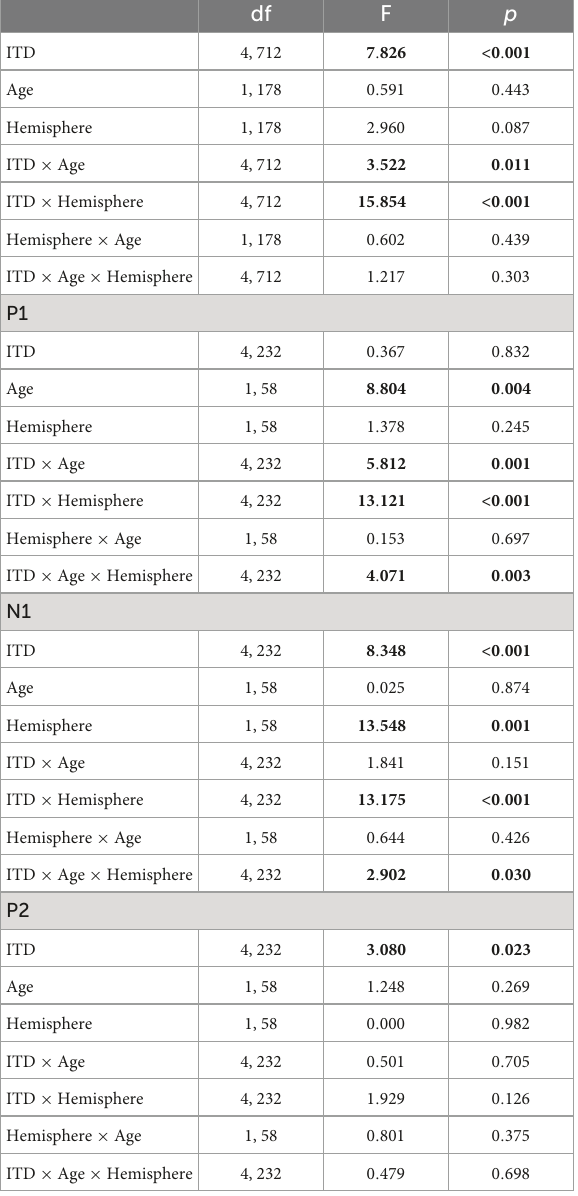
TABLE 3 Repeated-measures analysis of variance (ANOVA) results for cortical auditory evoked potentials (CAEP) source-localized measures. df F